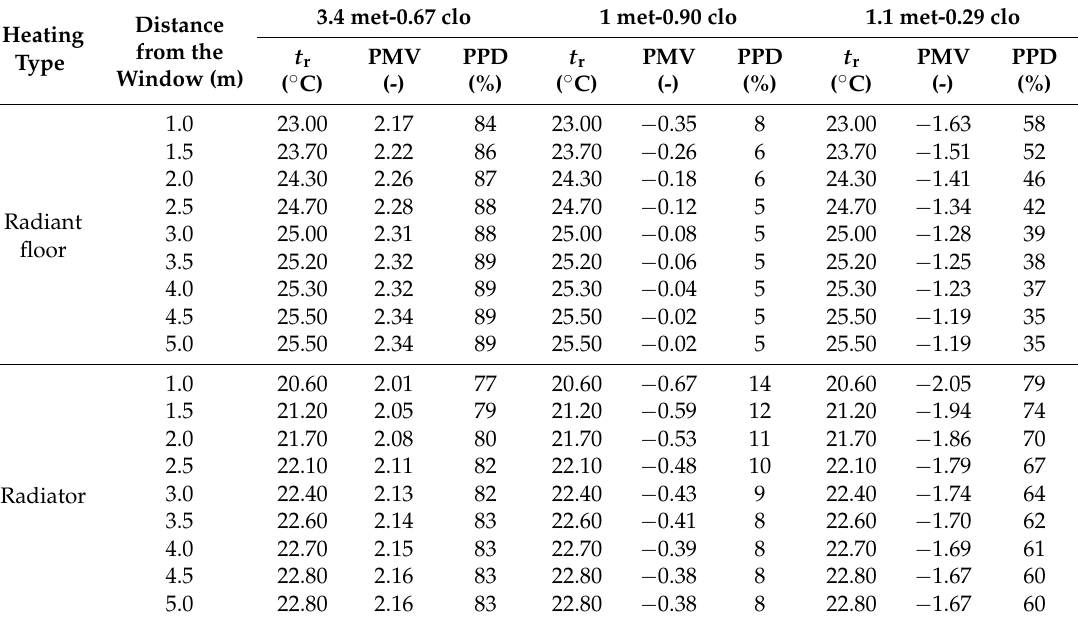
Table 2. Numerical results of THERMAL COMFORT computer